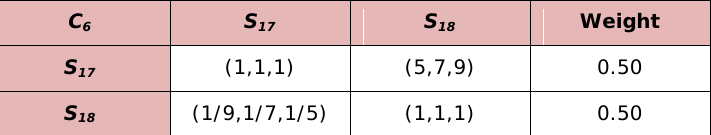
Table 8. “Fuzzy comparison matrix of the sub-criteria with respect to Mobility”.